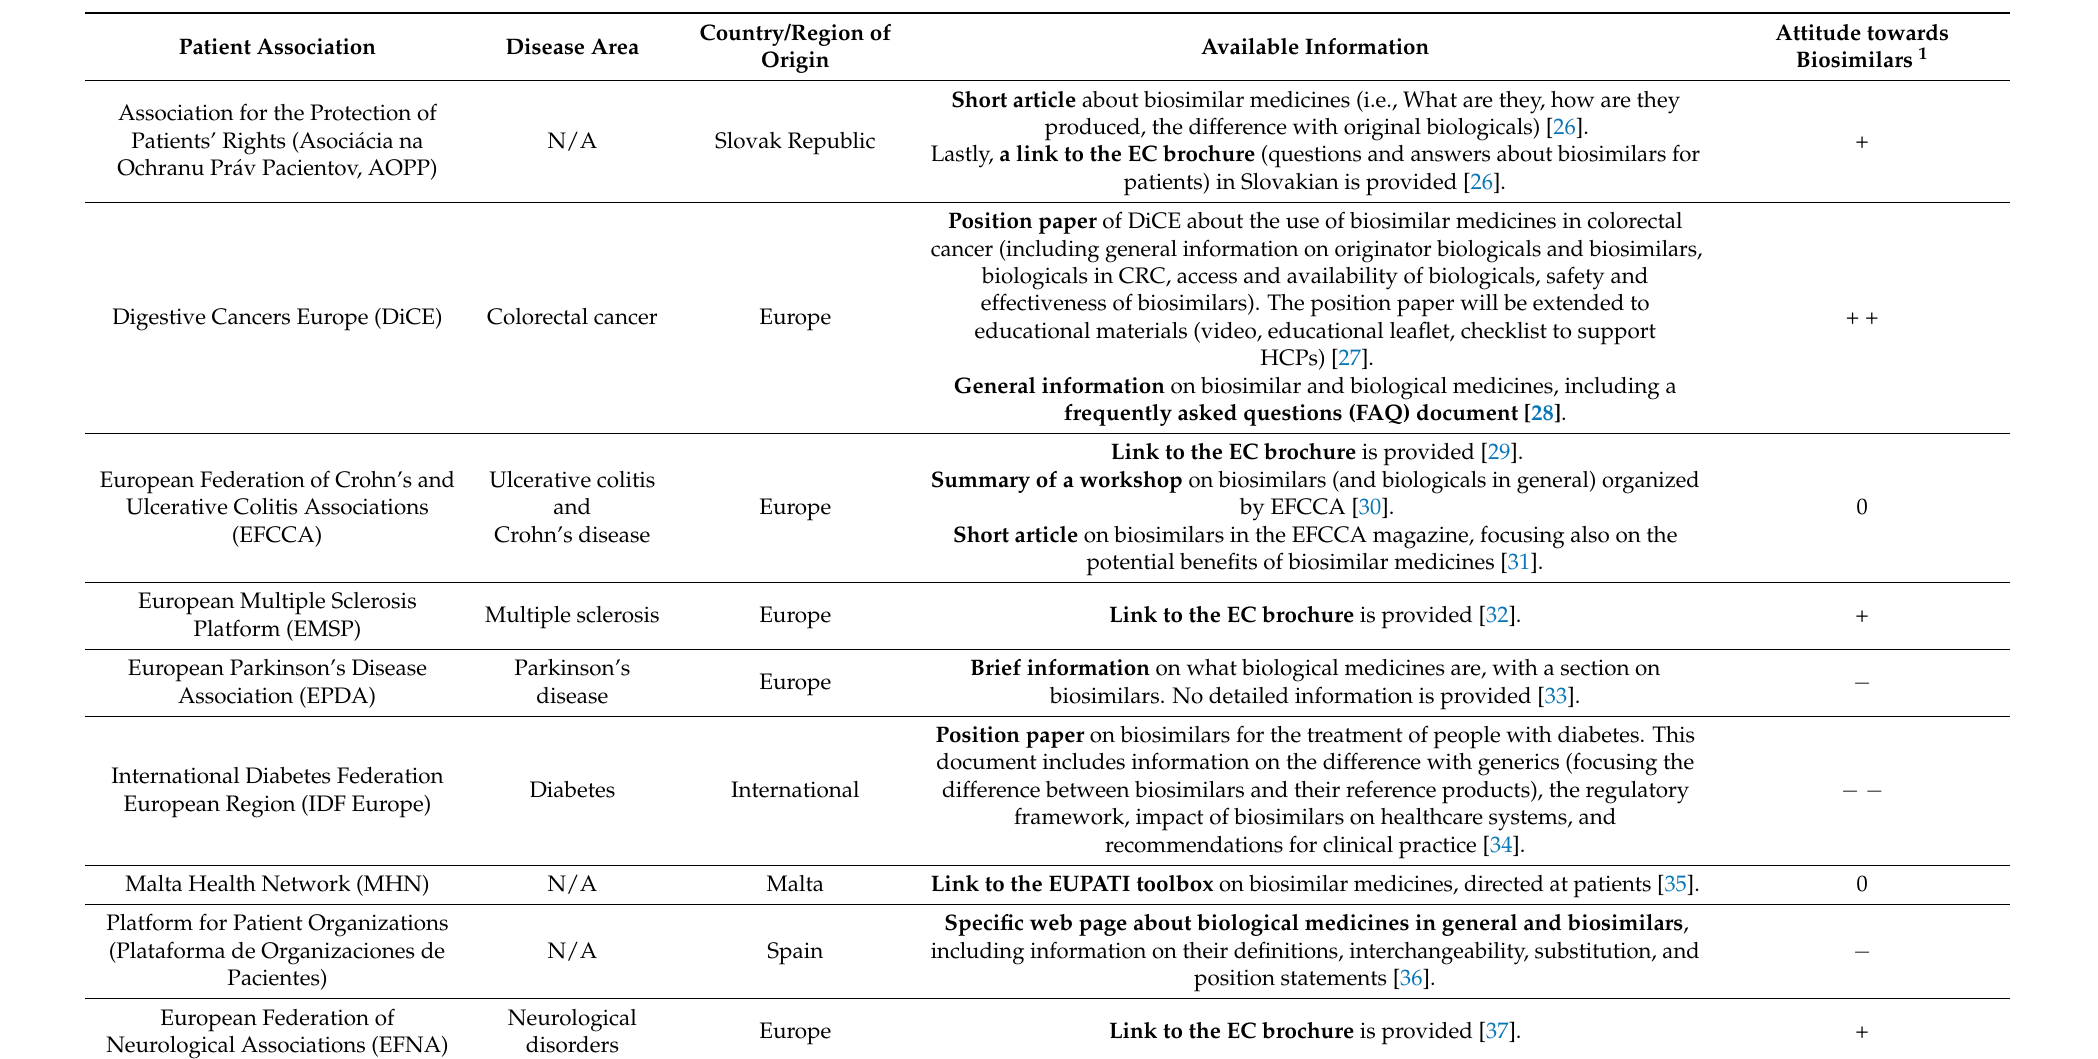
Table 1. European Patients’ Forum (EPF) and International Alliance of Patients’ Organizations (IAPO) members providing biosimilar information for